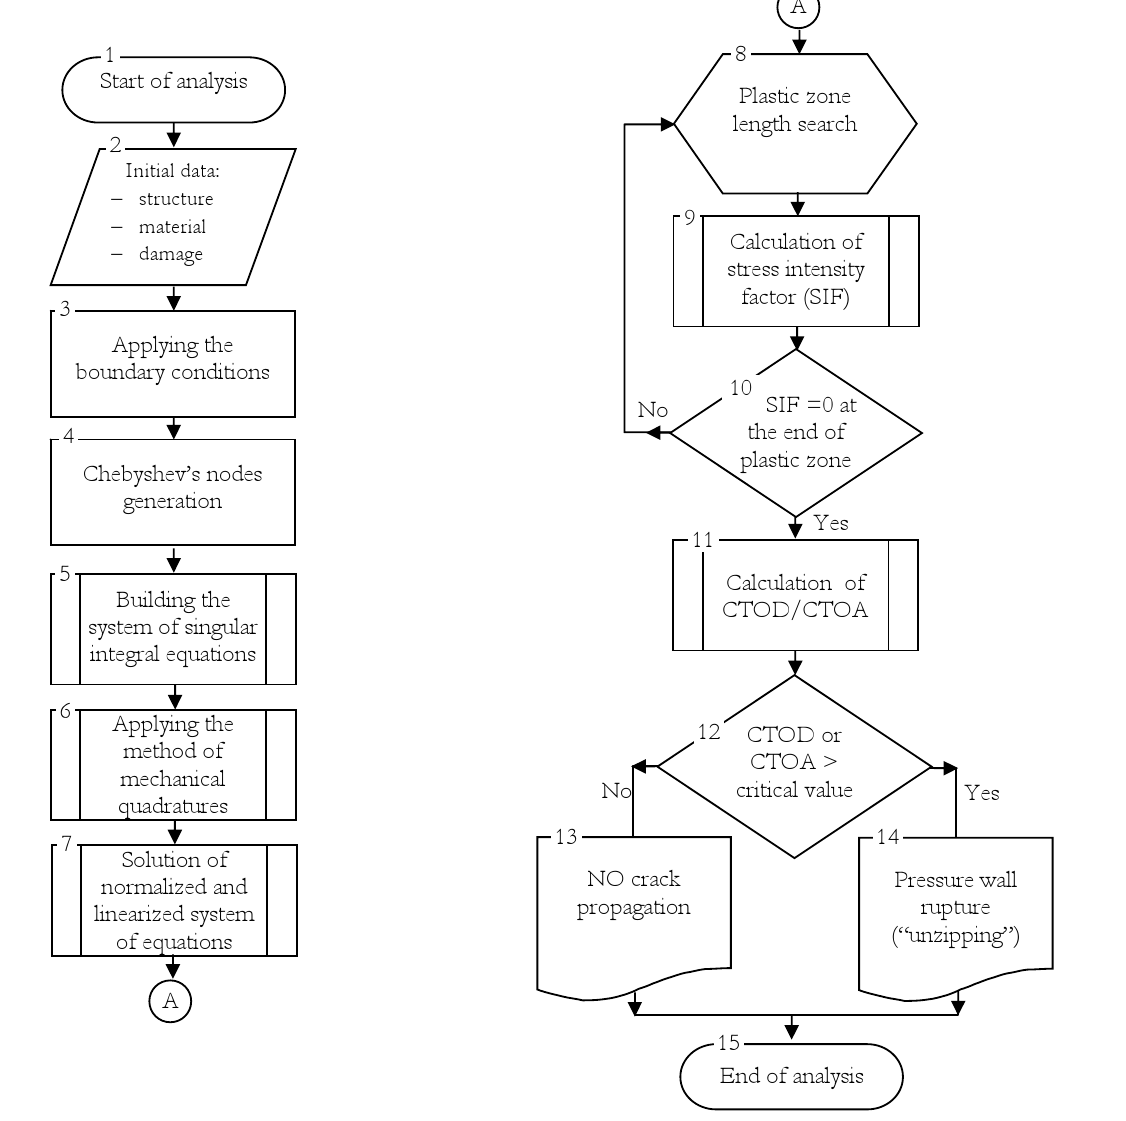
Figure 5: Steps of the fracture